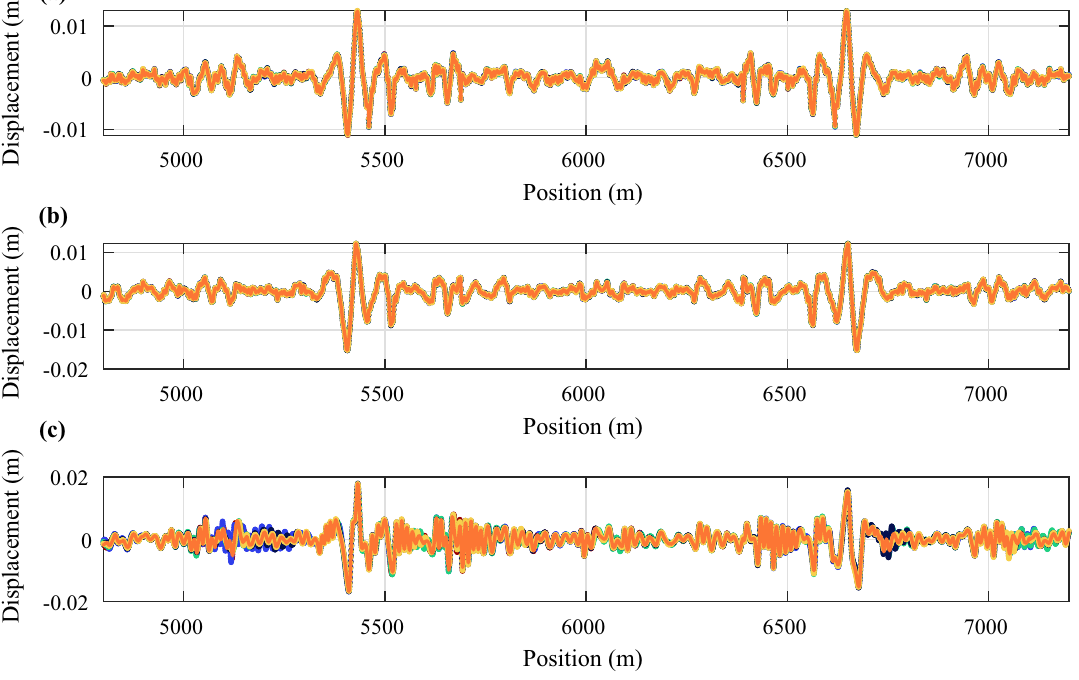
Fig. 19 Results from five simulations where noise using three times the standard deviation from LOO (ALOO) was added and the original simulation (no noise added), with the same color scheme and a , b and c as in Fig. 18. Some deviations from the original simulation can be